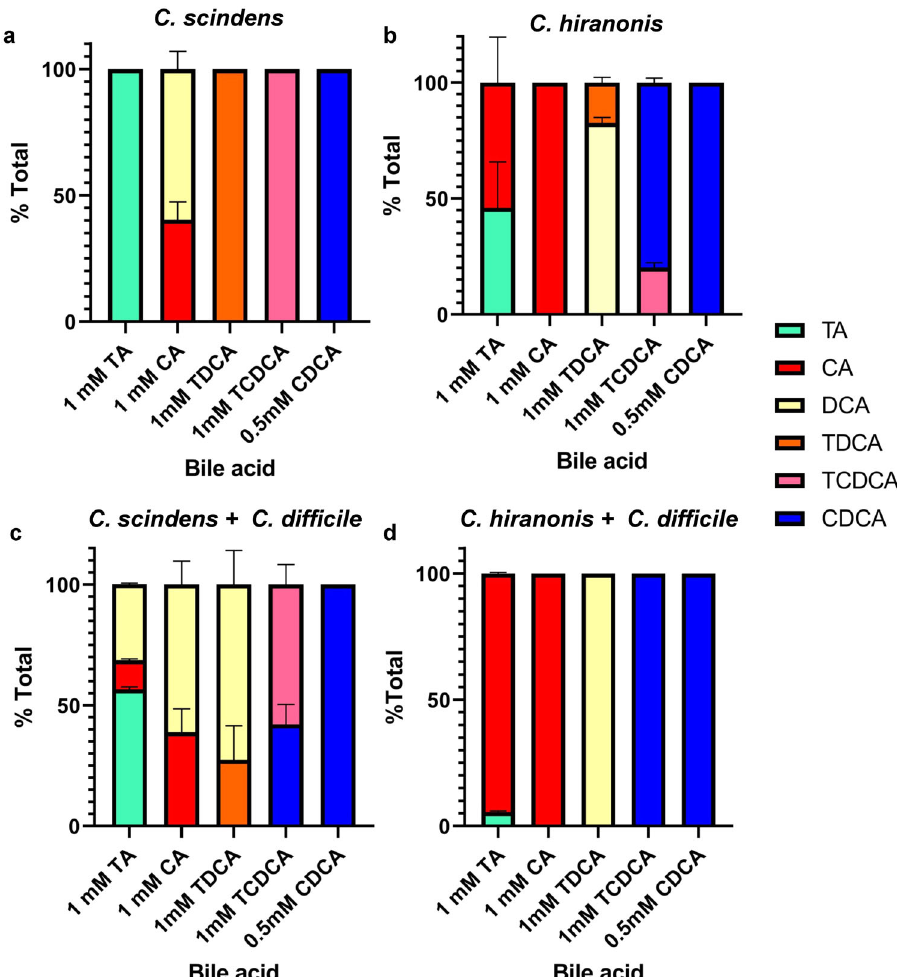
Fig. 6 C. dif fi cile BSH activity can feed CA to gut microbes. C. scindens ( a ) or C. hiranonis ( b ) overnight cultures were back diluted to 10 8 CFU/ mL and grown in the presence of the indicated bile salts for 24 h at 37 °C in an anaerobic environment. c C. scindens and C. dif fi cile or d C. hiranonis and C. dif fi cile overnight cultures were back diluted to 10 6 CFU/mL and grown in the presence of the indicated bile salts for 24 h at 37 °C in an anaerobic environment. Values were calculated by measuring the peak areas for the indicated bile salt and expressed as a percentage of the total input. HDCA was included as an internal standard. Values shown are the average of three different independent experiments, and error bars represent the standard error of the